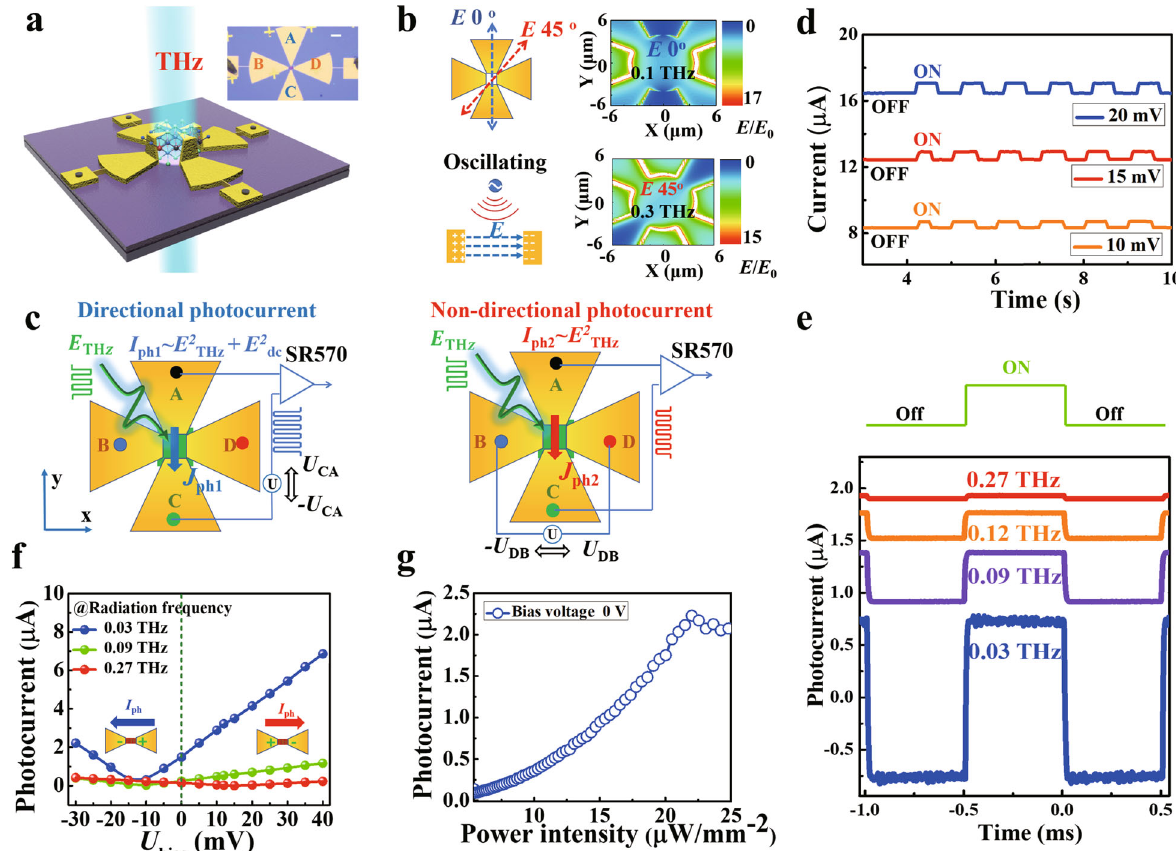
Fig. 2 The EuSn 2 As 2 fl akes-based THz detector and its photoresponse features. a Schematic illustration of the detector exploiting EuSn 2 As 2 fl akes integrated with multiple bow-tie antennas; inset: an optical micrograph image of the detector with the scale bar of 50 μ m. b The FDTD simulations of the fi eld distributions in the antenna gap at 0.1 and 0.3 THz radiation with incident polarization angles of 0 o and 45 o . Right side, the antenna-coupled incident electric fi eld ratio E / E 0 onto the active area. c THz detection with two representative photocurrents (directional and non-directional photocurrents), where E THz is the THz fi eld, E dc is the applied DC electric fi eld and J ph ( J ph1 and J ph2 ) is the photocurrent density. d , e Temporal photocurrent I ph at bias voltage range of 10 – 30 mV and under 0.02 – 0.27 THz radiation; “ ON ” and “ OFF ” stand for illumination and no illumination, respectively. f Photocurrent ( I ph-CA or I ph - DB ) as a function of the bias voltage U bias ( U CA or U DB ) under 0.03 THz, 0.09 THz and 0.27 THz radiation. g Photocurrent ( I ph ) as a function of the power density ( P density ) at a zero-bias